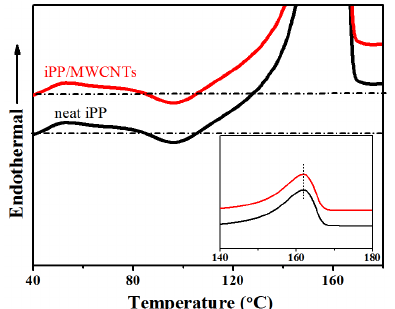
Figure 8. Differential scanning calorimeter (DSC) heating curves of the two kinds mesomorphic samples with the inset of the melting peak region.